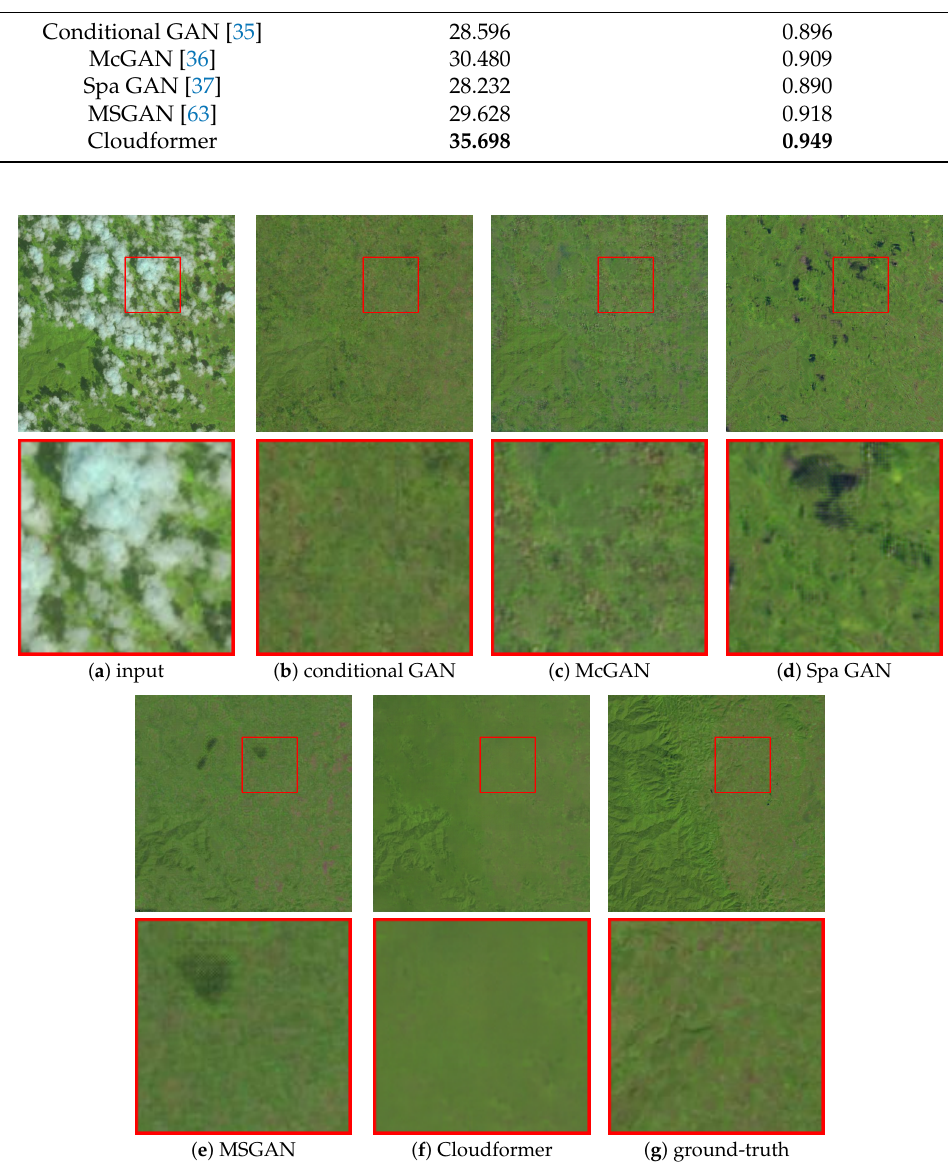
Figure 12. Comparative experimental results on the second sample of RICE2. When there are medium-sized clouds in the image, Spa GAN and MSGAN produce black blocks. Conditional GAN cannot completely remove cloud shadows. The result of McGAN shows a lot of color distortion. In contrast, our method maintains the tonal consistency of the